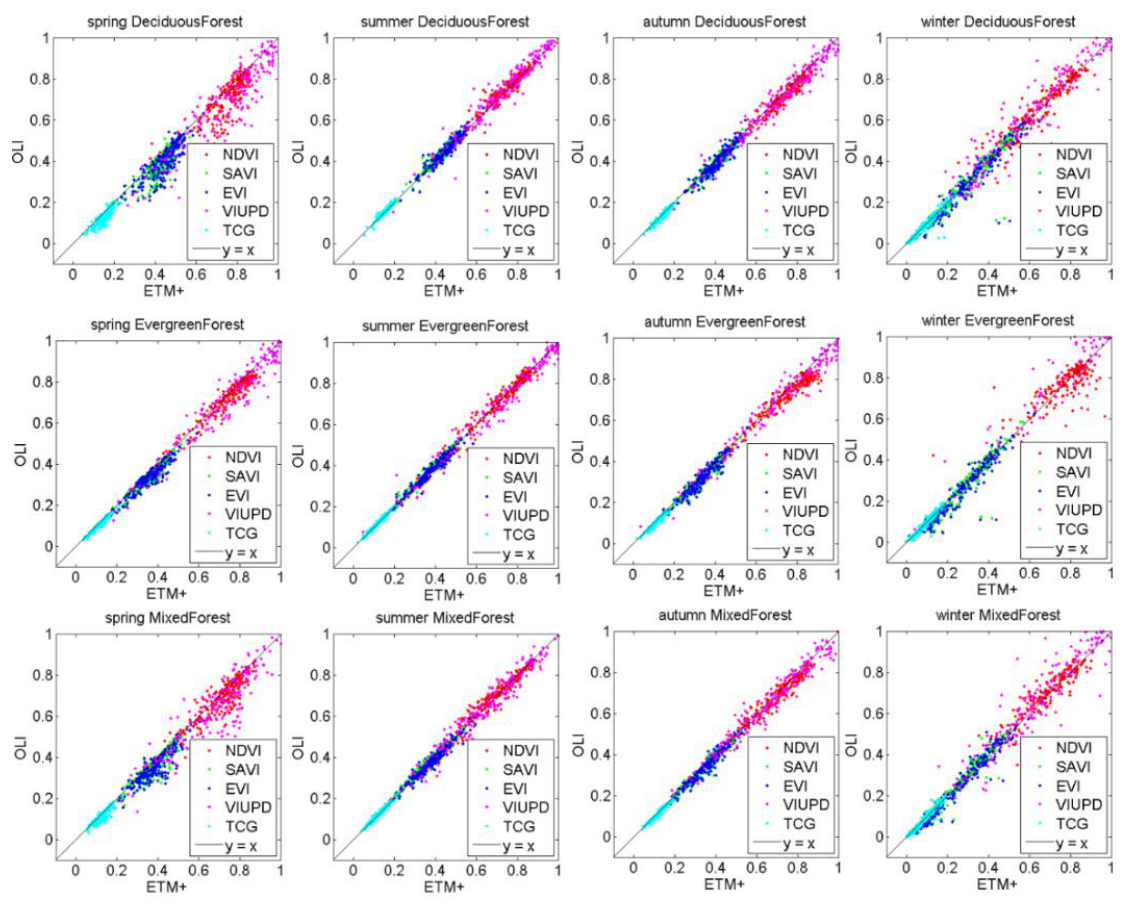
Figure 7. Scatterplots showing the correlational relationships among five VIs as derived from Landsat 7 ETM+ and Landsat 8 OLI data for three forest types during the four seasons. Among the 12 scatterplots, deciduous forest, evergreen forest, and mixed forest are shown on the vertical axis, with spring, summer, autumn, and winter on the horizontal axis. The VIs of the three forest types were markedly higher than for the non-forest land cover types, with the exception of crops. For clarity, the X- and Y -axis maxima for forests were set to 1, while those of the non-forests were set to 0.5. The linear relationship equations for each VI derived from every 1000 random samples for each vegetation class in each season are displayed in Table 3. The determination coefficients ( R 2 ) based on the linear correlations of the five VIs derived from ETM+ and OLI data for the four seasons are shown in Table 4. The red color indicates the highest correlation, and green indicates the lowest correlation. For each record, 1000 random samples were used in the regression